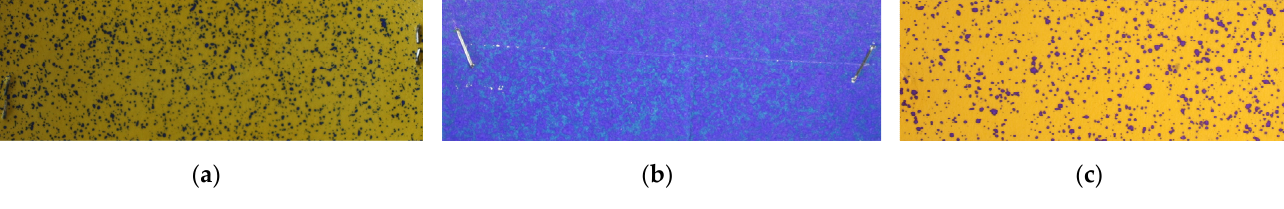
Figure 7. Difference about water-sensitive paper after using: ( a ) Reference card used for previous works. ( b ) WSP used for the field trial of 29 October 2021. ( c ) Example of WSP (similar to the reference card) used for the field trial of 21 October 2022 in worse condition.